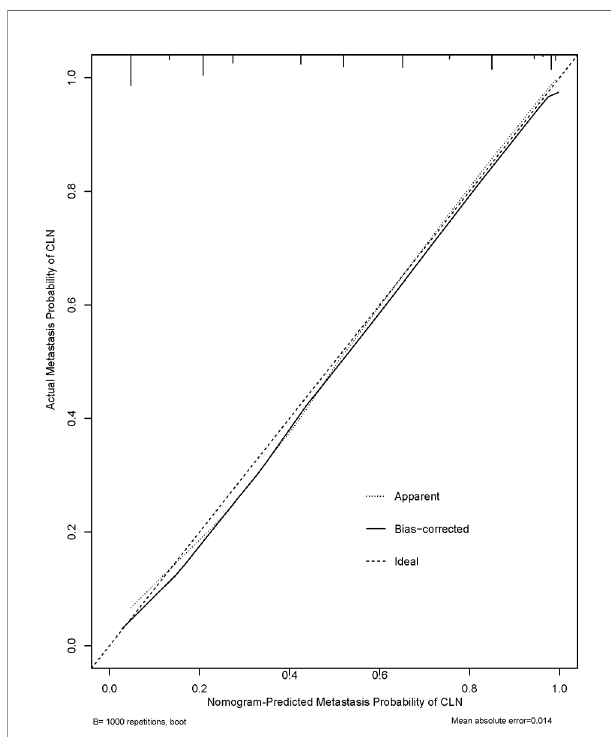
FIGURE 4 | Calibration curves of the nomogram for predicting CLNM in PTMC